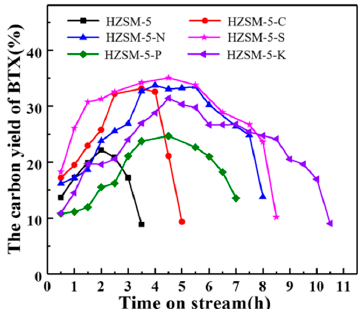
Figure6. ThetotalcarbonyieldofBTXobtainedbyHZSM-5zeolitessynthesizedwithdi ff erentadditives. Figure 6. The total carbon yield of BTX obtained by HZSM-5 zeolites synthesized with different additives.